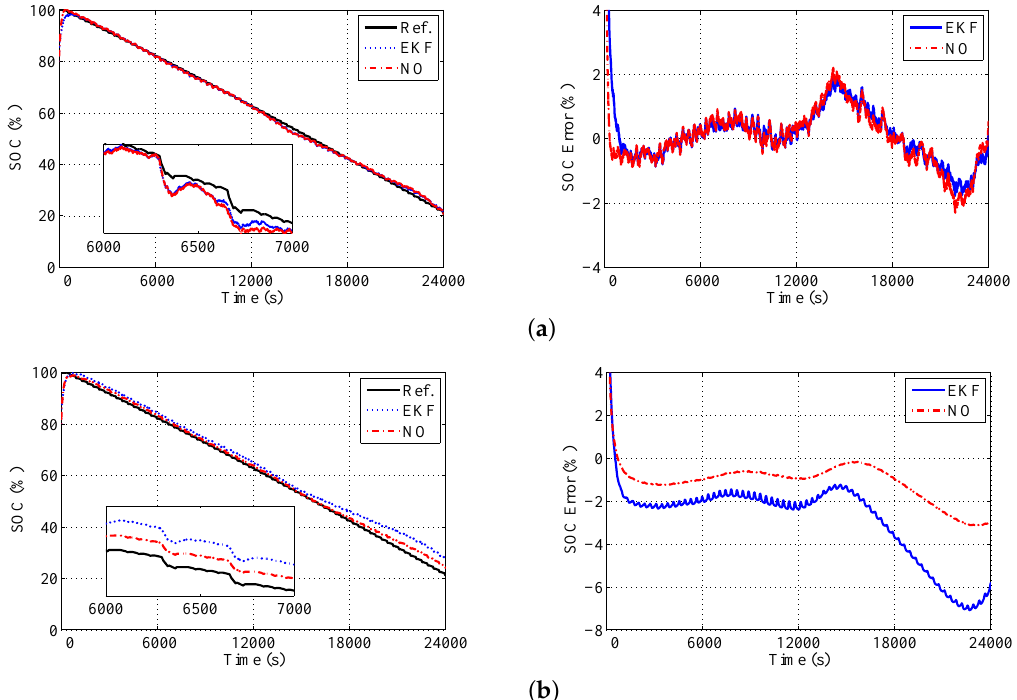
Figure 8. Robustness validation 1, measurements with noise and sensor basies: ( a ) with voltage and current measurement noise; and ( b ) with current sensor biases.